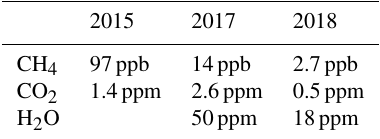
Table 1. Evolution between 2015 (with two single-gas versions for CO 2 and CH 4 ) and 2018 of AMULSE sensitivities with respect to years and measurable molecular species. It highlights an increas- ing improvement in the performance of the instrument. It shows the standard deviation over a 1s integration